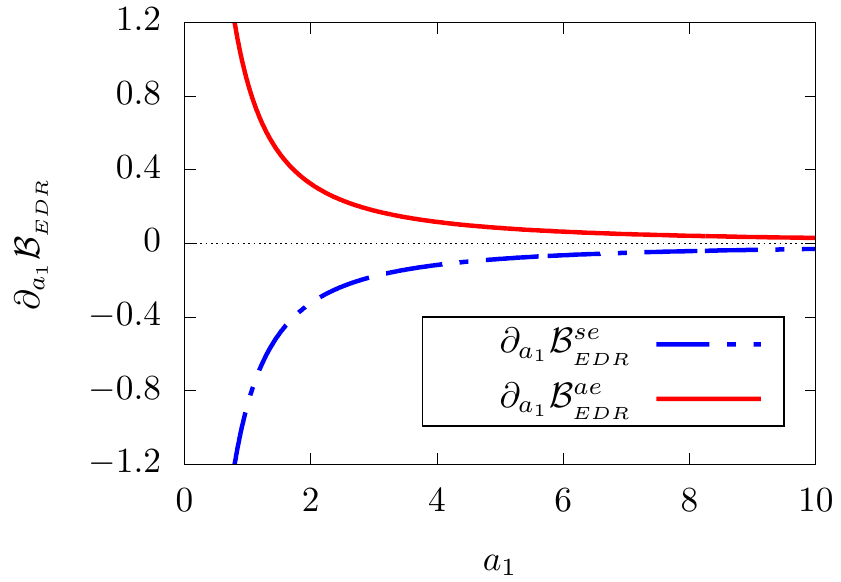
Figure 15 . The quantity ∂ a B se is plotted with respect to varying a 1 for accelerated atoms 1 EDR in thermal background considering Rindler modes, depicted by dash-dotted blue line. The quan- tity ∂ a B ae is plotted with respect to varying a 1 for accelerated atoms in thermal background 1 EDR considering Rindler modes, depicted by solid red